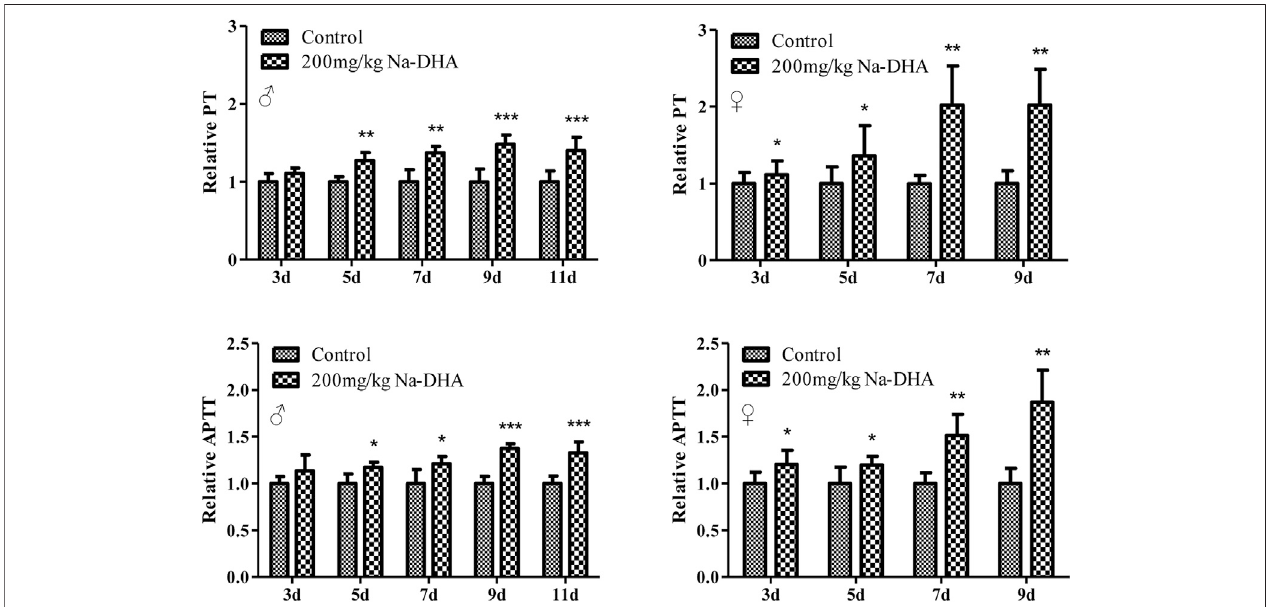
FIGURE1| TherelativePTandAPTTinratstreatedwithNa-DHA.WistarratswereadministeredNa-DHAatadoseof200mg/kgbygavage.PTorAPTTvaluesofsixmales orfemalesineachgroupweremeasuredbyanautomatedbloodcoagulationanalyzer,andtherelativevalueswerecomparedtothoseinthecontrolplasma.* p < 0.05,** p < 0.01, *** p < 0.001, signi fi cantly different from controls.